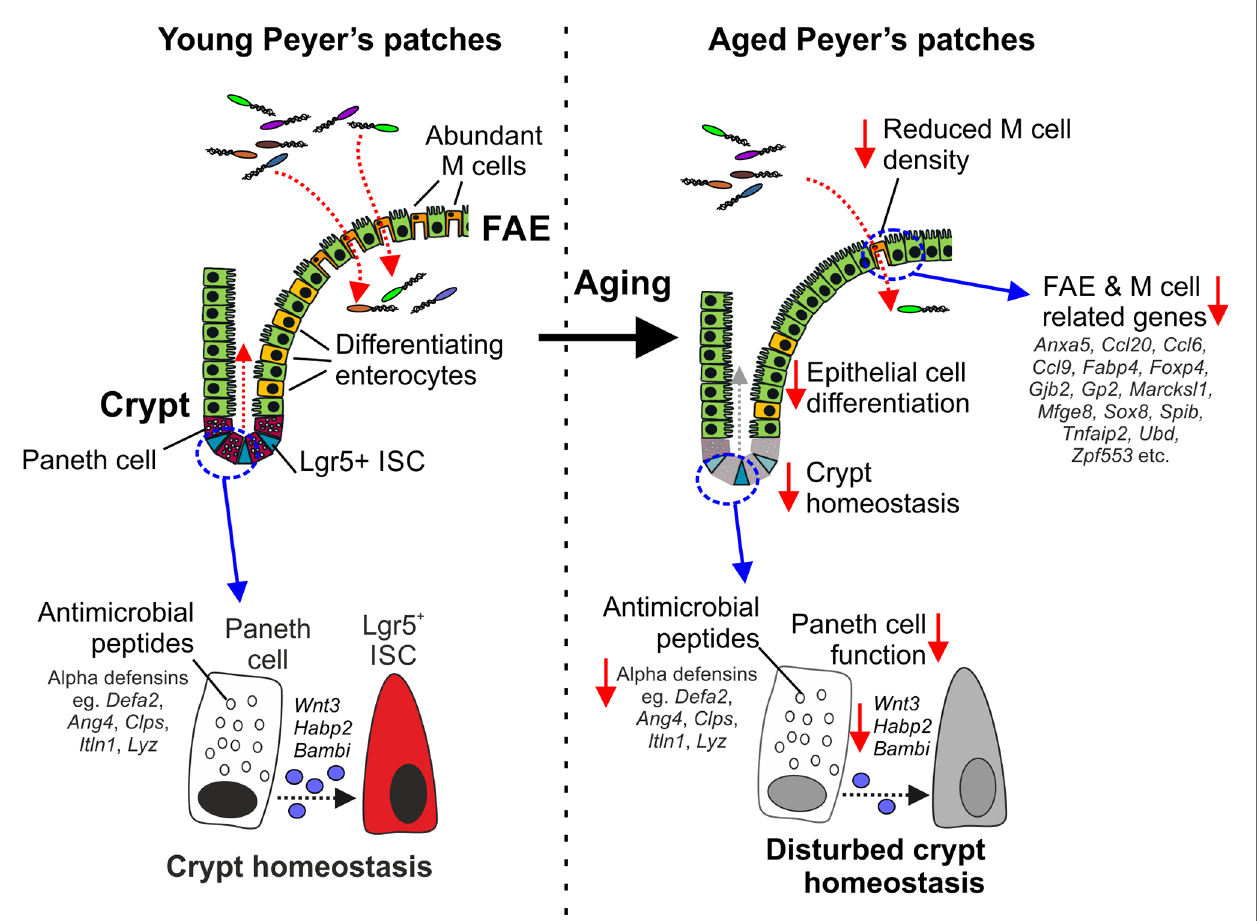
FIGURE 7 | Cartoon describing the impact of aging on Paneth cells and M cells. Paneth cells in the young intestine secrete antimicrobial peptides that help to protect the crypts from bacterial infection. Paneth cells also provide homeostatic support to Lgr5+ intestinal stem cells (ISC). In the aged intestine, the expression of genes encoding antimicrobial peptides and homeostatic support factors is reduced. The disturbed crypt homeostasis in the aged intestine affects epithelial cell differentiation and coincides with reduced M cell differentiation in the FAE, and reduced expression of FAE- and M cell-related